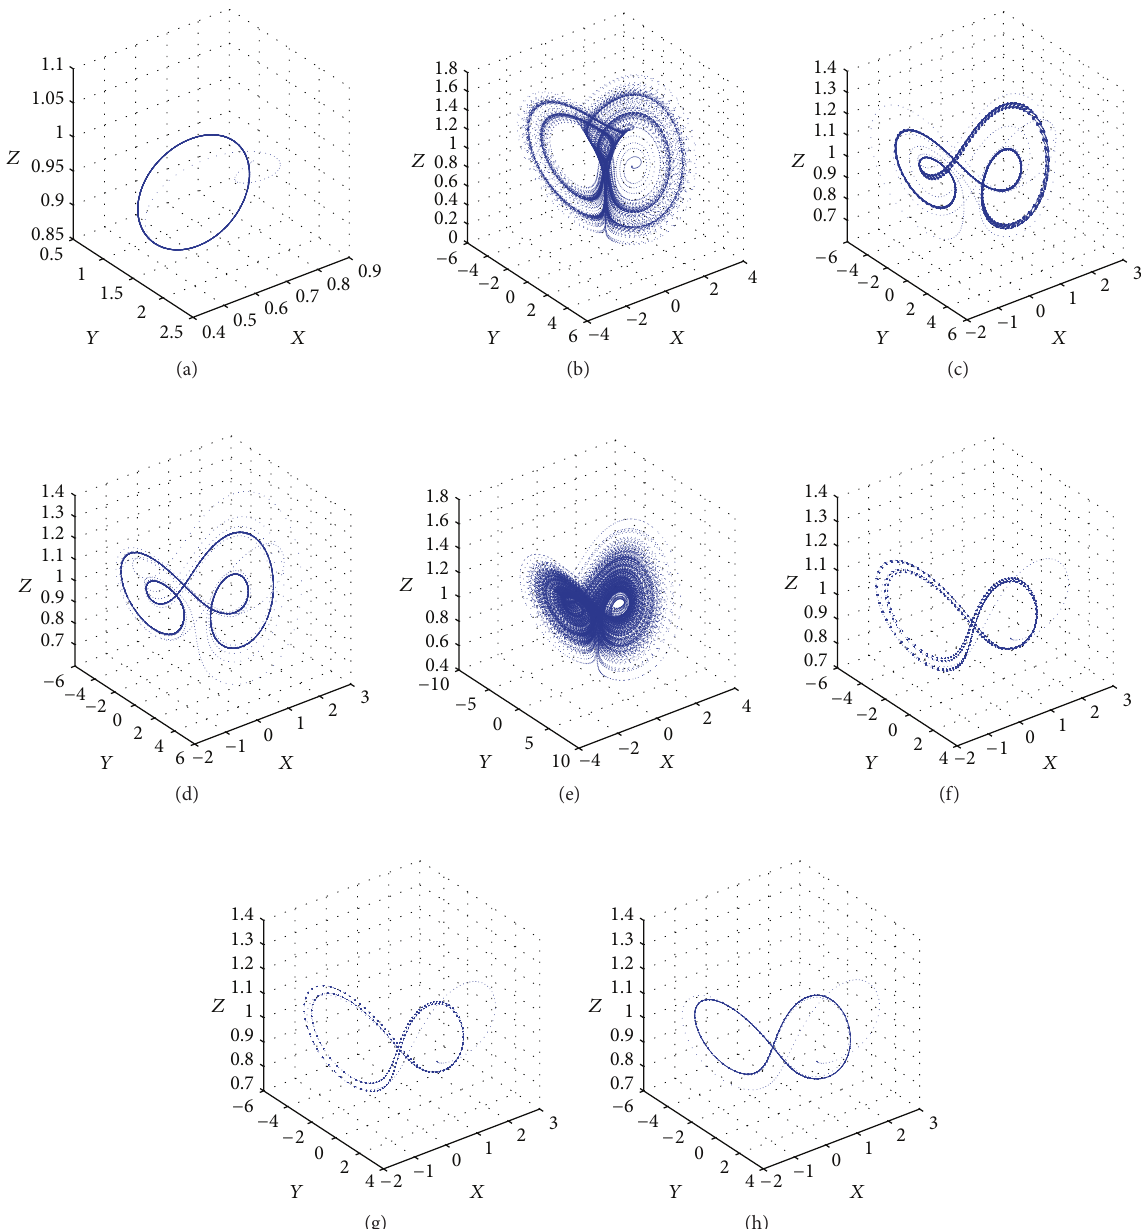
Figure 6: Phase portraits for (a) 𝑅 = 82 , (b) 𝑅 = 98 , (c) 𝑅 = 364 , (d) 𝑅 = 370 , (e) 𝑅 = 400 , (f) 𝑅 = 490 , (g) 𝑅 = 500 , and (h) 𝑅 = 600 for the case where Le = 0.1 , 𝑅 𝑠 = 30